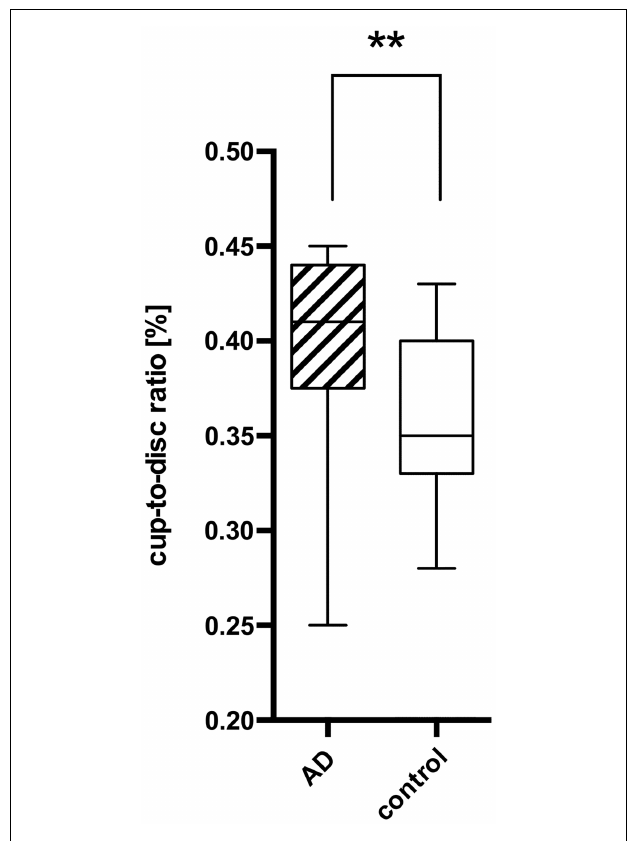
FIGURE 3 | Comparison of the cup-to-disk ratio (CD-ratio) betweenAD patients (AD) and controls (control) with a significant difference ( P = 0.001) indicated as ** .The mean CD-ratio of AD patients was 0.396, the one of the control patients